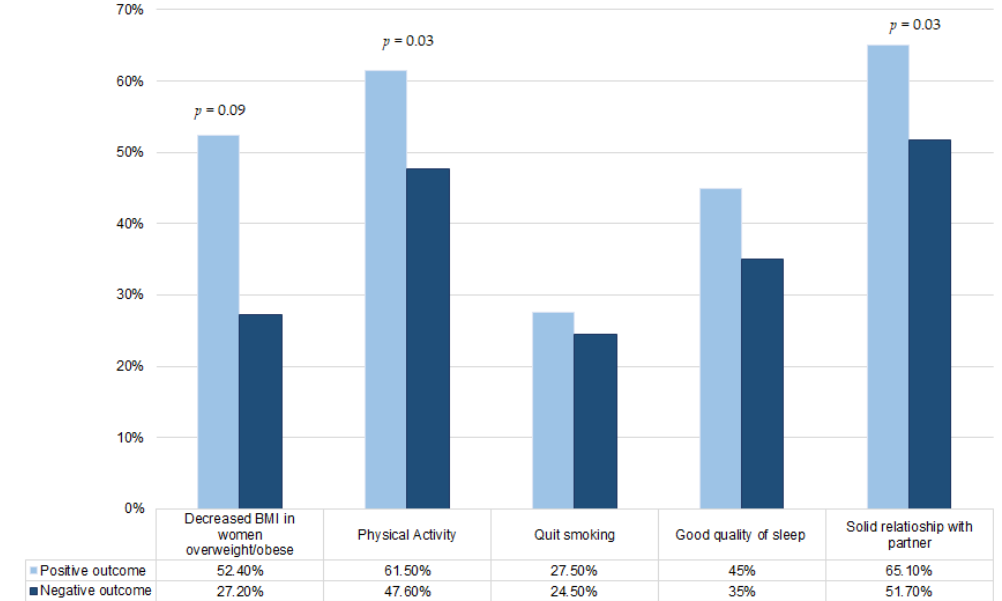
Figure 2. Distribution of variables (percentage of overweight/obese women who improved BMI, percentage of women who practiced physical activity, percentage of women who quit smoking, percentage of women who had good quality of sleep, percentage of women who had a solid relationship with partner) in women with positive ART outcomes vs. women with negative ART